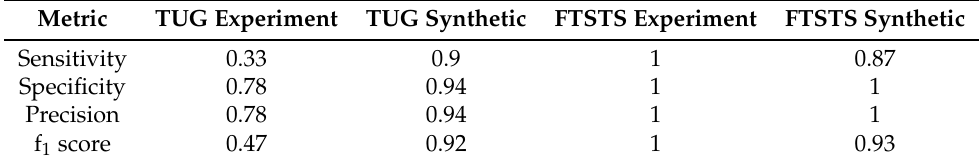
Table 3. Hybrid model confusion matrix